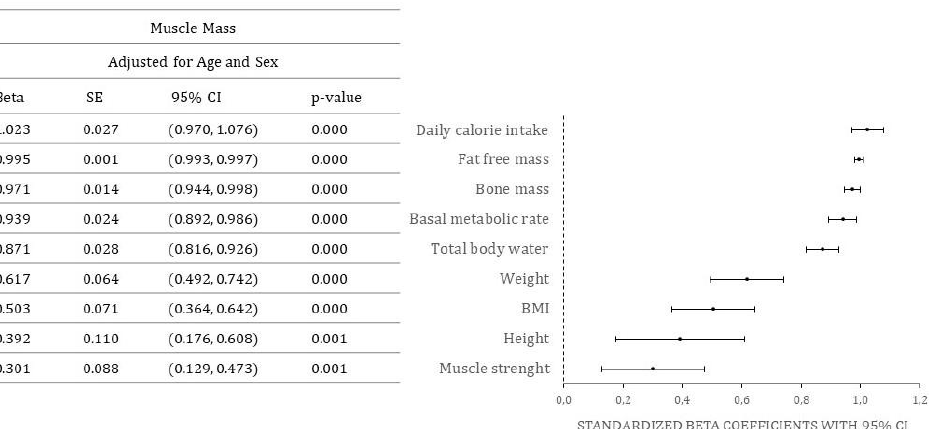
Figure 1. Predictors of muscle strength. Abbreviations: SE-standard error, CI-confidence interval, DAS-disease activity score, DAS ESR-disease activity score erythrocyte sedimentation rate, BMI- body mass index (kg/m 2 ).